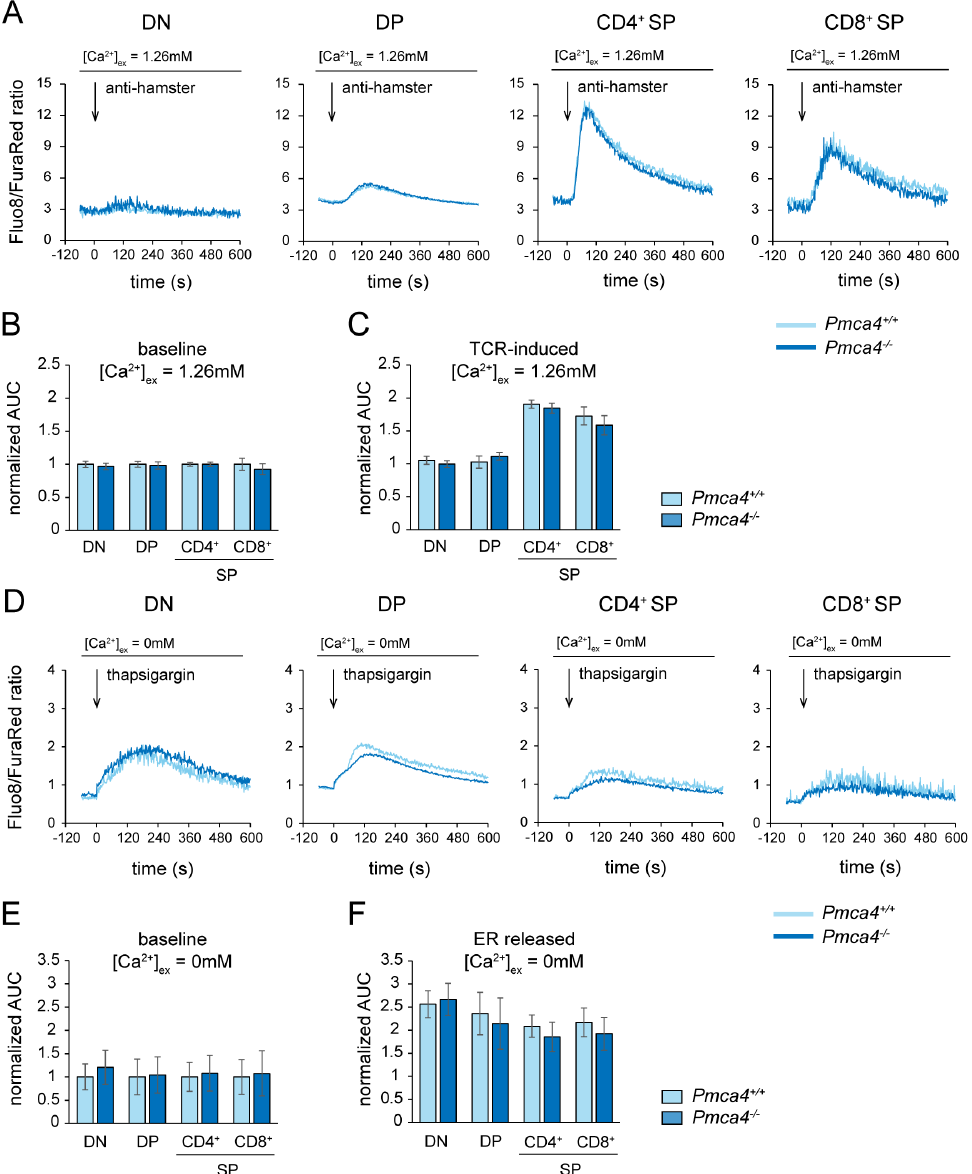
Figure 3. PMCA4 is not required for global intracellular Ca 2+ homeostasis during T cell development. ( A – C ) Flow cytometric ratiometric measurements of basal Ca 2+ level and TCR-induced Ca 2+ kinetics in Fluo-8 and FuraRed labeled thymocytes of Pmca4 +/+ and Pmca4 − / − mice in a Ca 2+ -containing buffer. The representative kinetic graphs ( A ) show changes of the Fluo-8/FuraRed ratio in anti-CD3 labeled DN, DP and SP thymocytes for 10 min upon the addition of a CD3 crosslinker (anti-hamster) after a one minute acquisition of the baseline level. For the quantification of basal ( B ) and TCR-induced ( C ) Ca 2+ levels, the AUC values were normalized to the corresponding basal value of the control as described in the methods section. The bar graphs show the mean normalized AUC values ± SD obtained from 3 experiments. ( D – F ) Flow cytometric ratiometric measurements of the basal Ca 2+ level and kinetics of Ca 2+ release from the ER upon the blockage of SERCA in the thymocytes of Pmca4 +/+ and Pmca4 − / − mice in a Ca 2+ -free buffer. The kinetic graphs ( D ) show changes of the Fluo-8/FuraRed ratio in DN, DP and SP thymocytes for 10 min upon the addition of thapsigargin following a one minute baseline acquisition. For the quantification of basal Ca 2+ levels in the Ca 2+ -free buffer ( E ) and ER Ca 2+ release ( F ), the AUC values were normalized to the corresponding basal value of the control. The bar graphs show the mean normalized AUC values ± SD obtained from 5